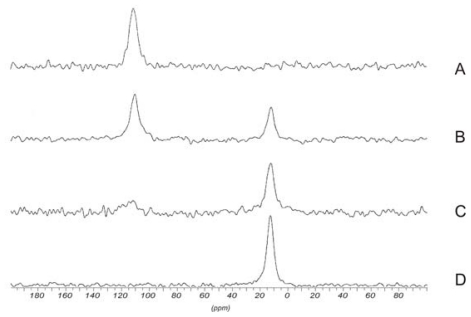
15N CP-MAS NMR spectra of samples A-D (with decreasing DA; ~100%, ~60%, ~20%, ~0%). Reprinted with permission from Biomacromol. 2000, 4, 746–751. Copyright 2010, ACS Publications [280].